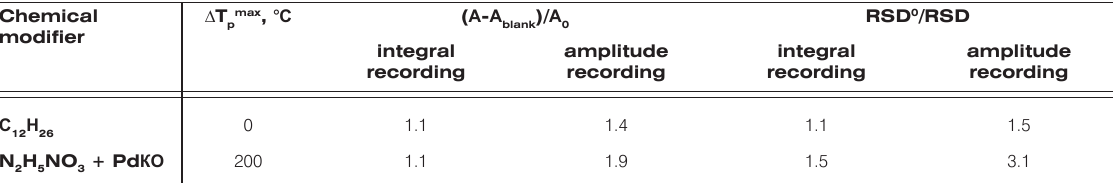
Table 4. Efficiency of Sb(V) hyphenated ETAAS determination (solution of BG in toluene). Chemical